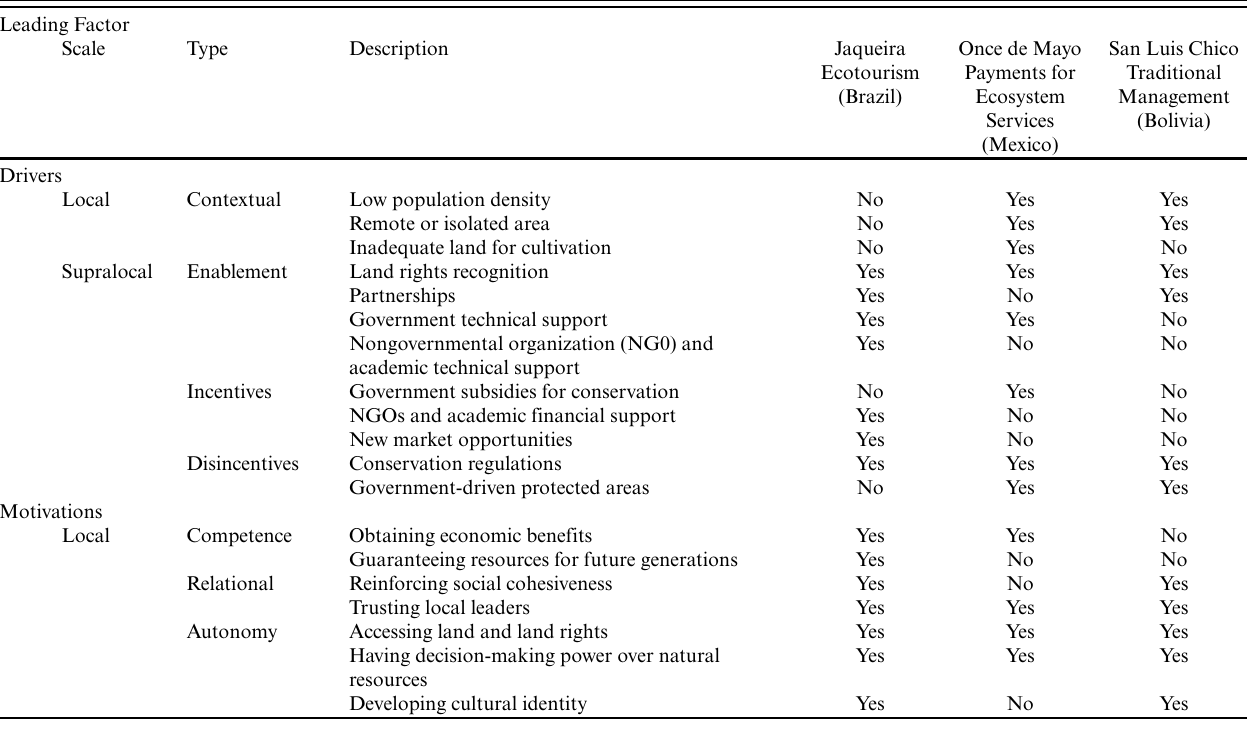
Table 3 . Relevant drivers and motivations of our studied community-based conservation initiatives. Leading Factor